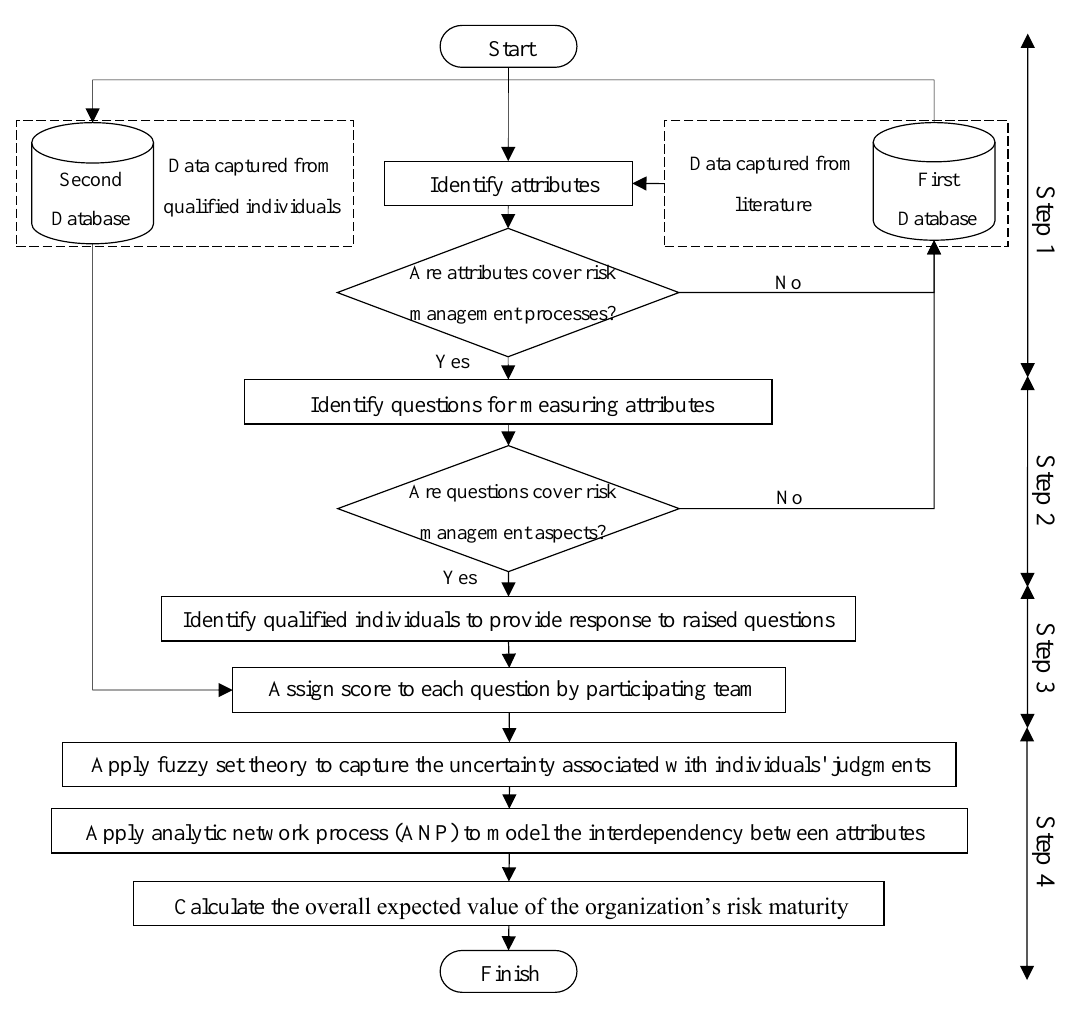
Figure 1. Framework of the developed model.